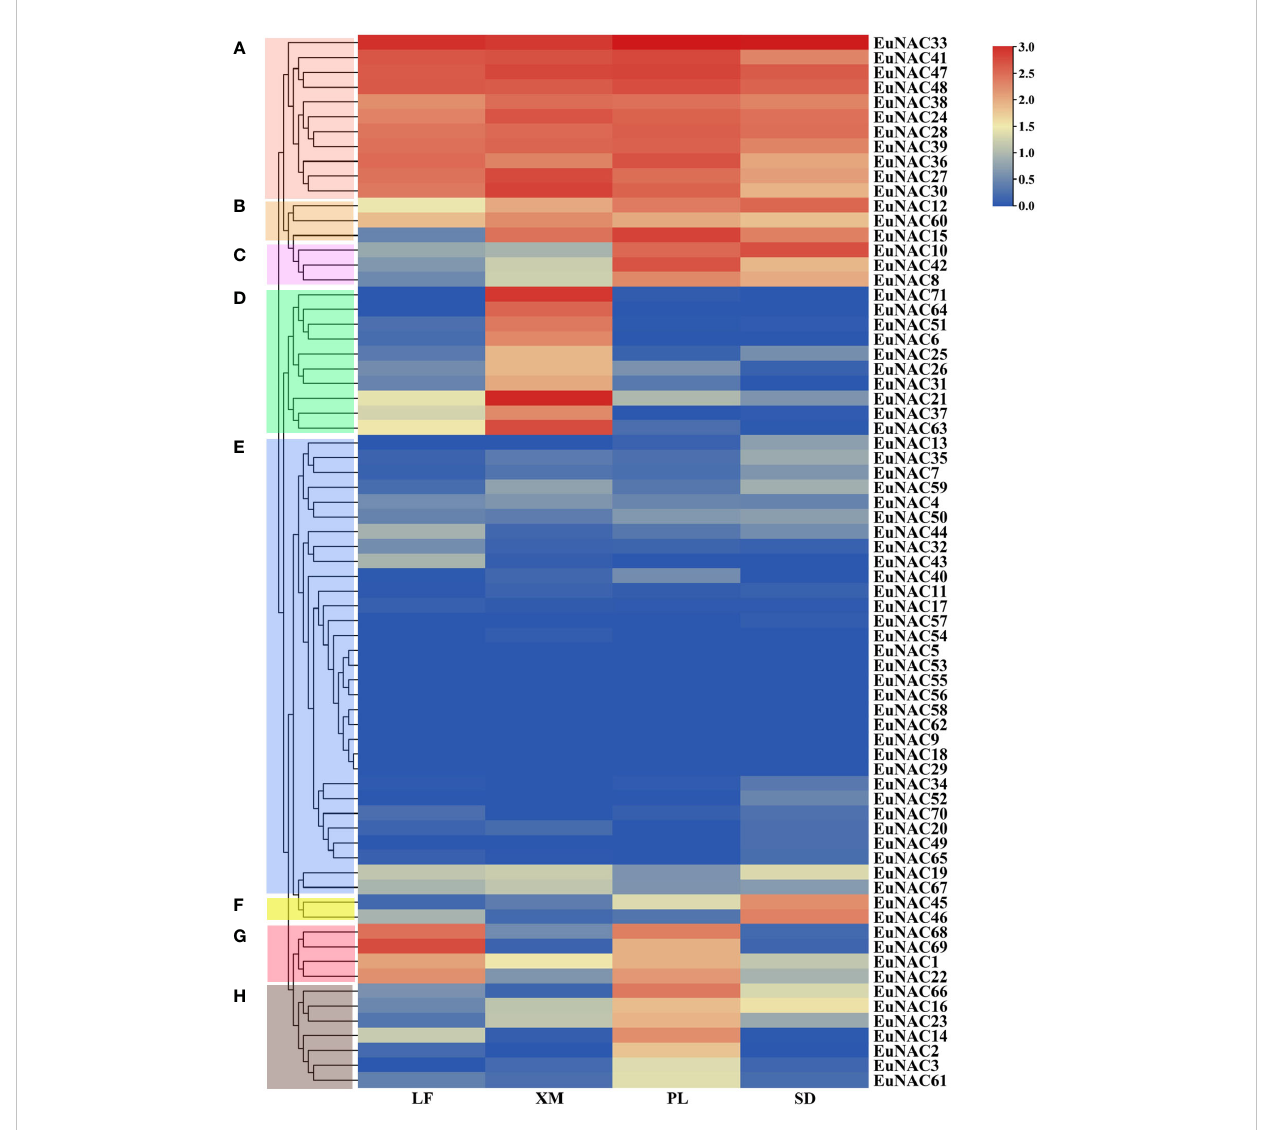
FIGURE 8 Expression levels of 71 EuNAC genes in different tissues. The expression level was presented based on the transformed data of log2 (FPKM+1) values. A total of 71 EuNAC genes were divided into (A – H) groups based on their expression levels. LF leaf; PL peel; XM xylem; SD